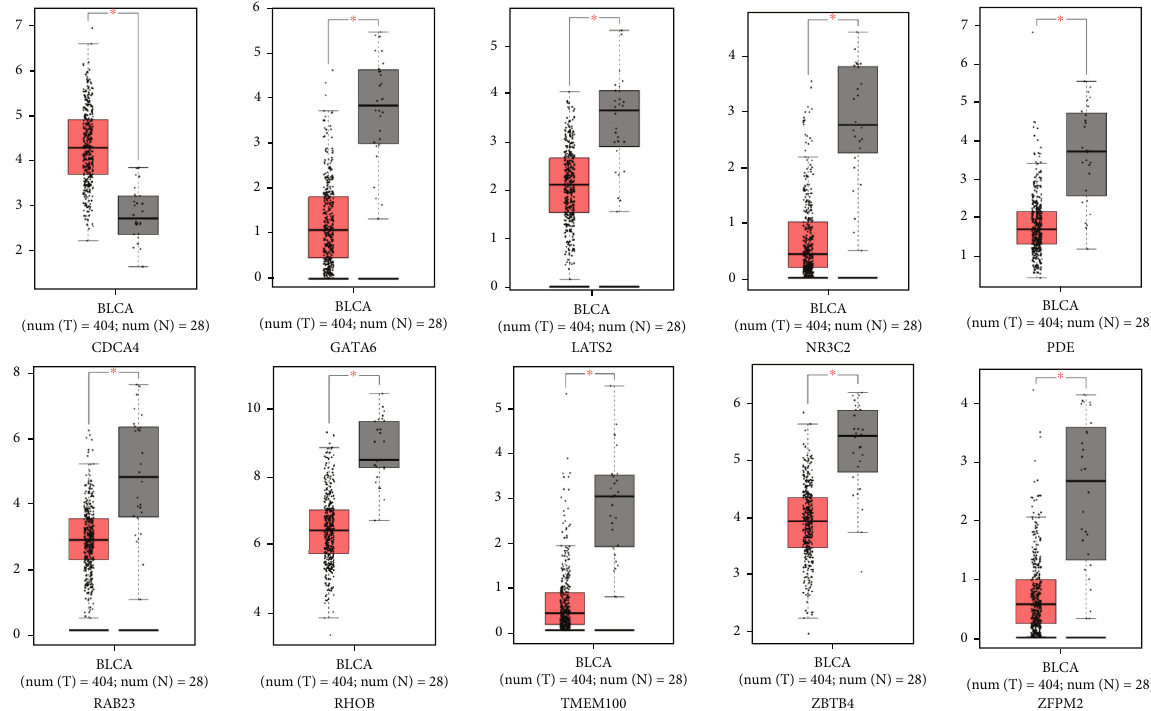
Figure 7: Expression pro fi les of the top 10 hub mRNAs between bladder cancer and normal groups. The signi fi cant di ff erence was under the condition of P value < 0.05.